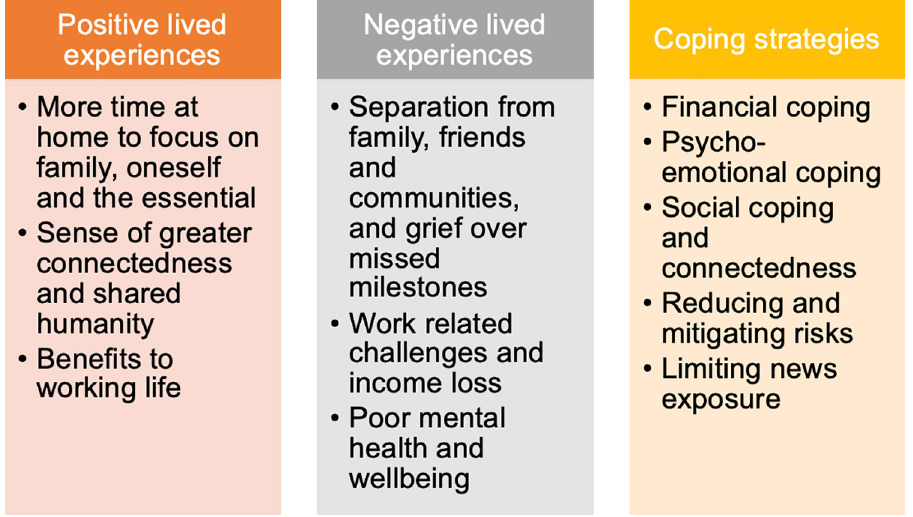
Fig 2. Lived experiences and impact of living under COVID-19 public health measures in four countries. Summary of key positive experiences, negative experiences and coping strategies.